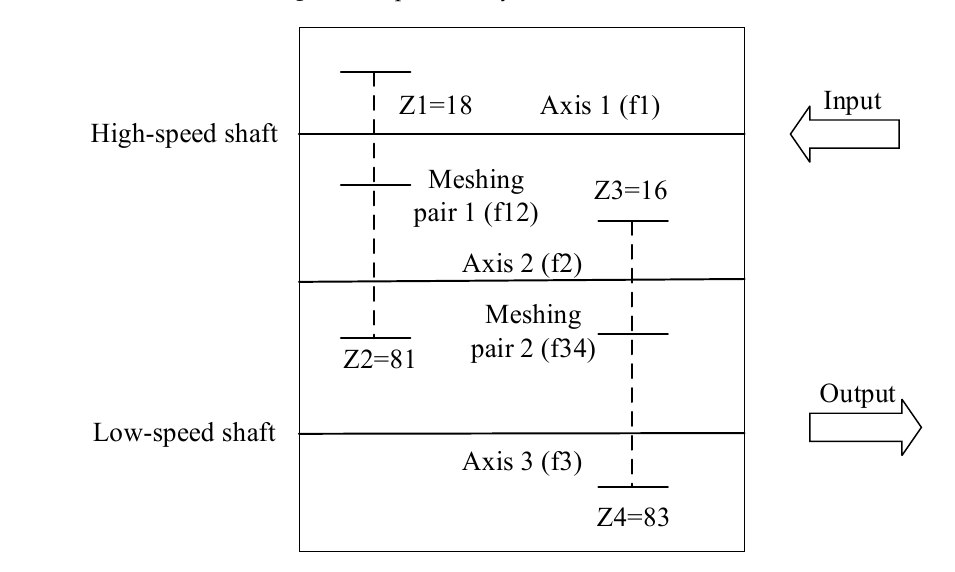
Figure 5. The sketch map of two-stage gearbox.